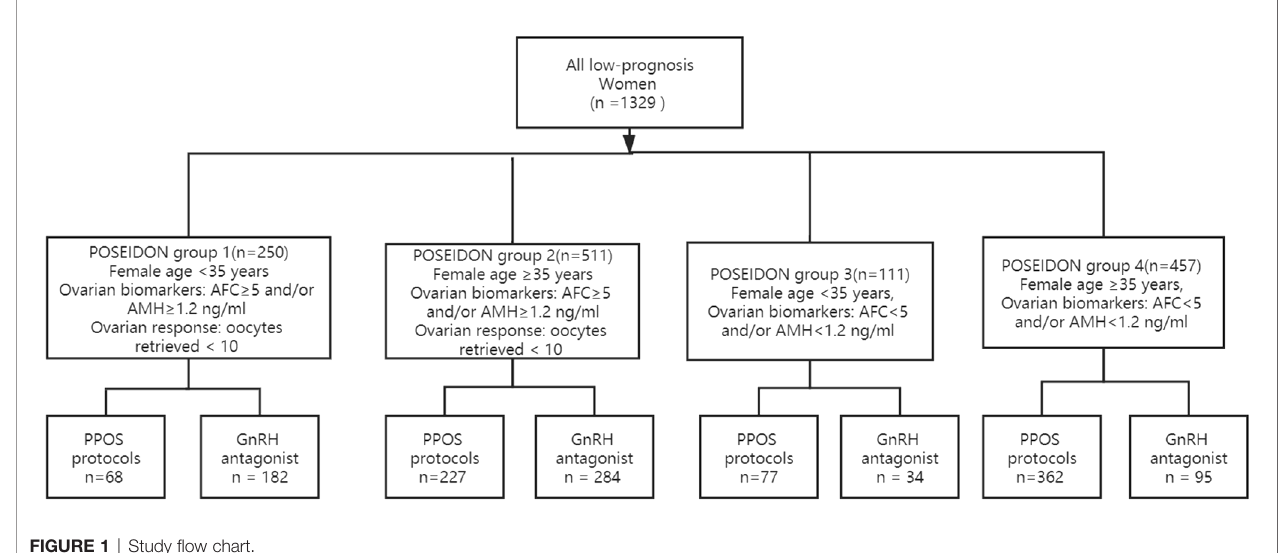
FIGURE 1 | Study fl ow